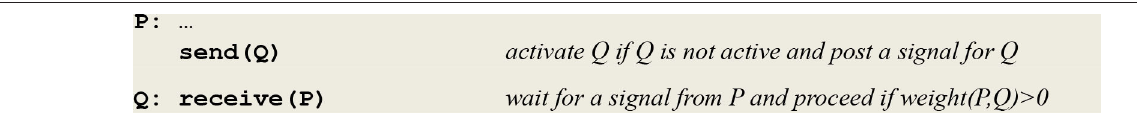
Frontiers in Neurorobotics |